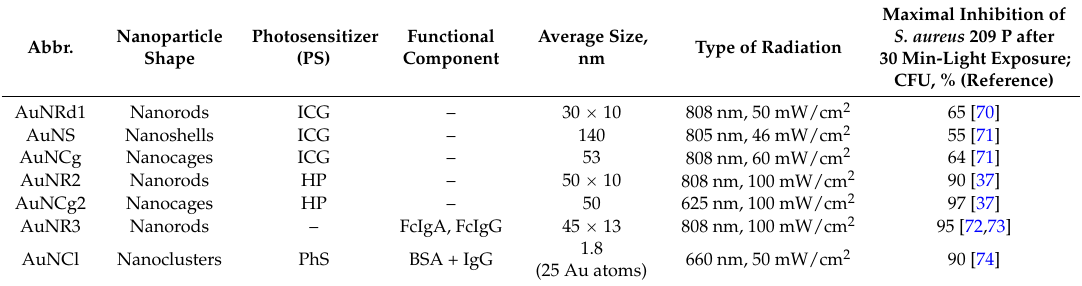
Table 1. Nanoparticles, PSs and experimental conditions for treatment of